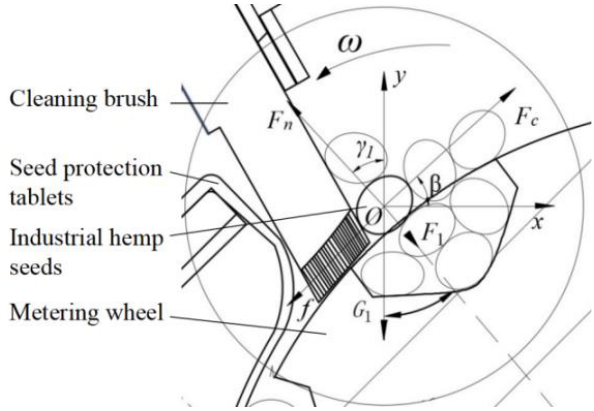
Figure 6. Seed cleaning process analysis.